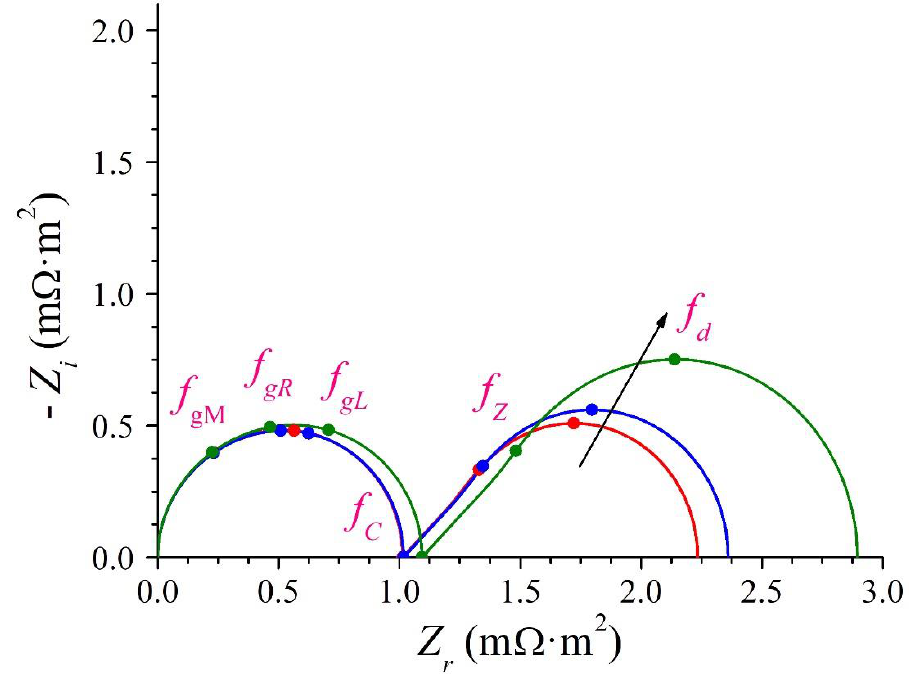
Figure 3. Nyquist plot of the impedance of ion-exchange membrane systems for I DC / I L = 0, 0.25 and 0.5. The arrow indicates increasing values of I DC . Table 1. Parameters of the electric circuit shown in Figure 2.